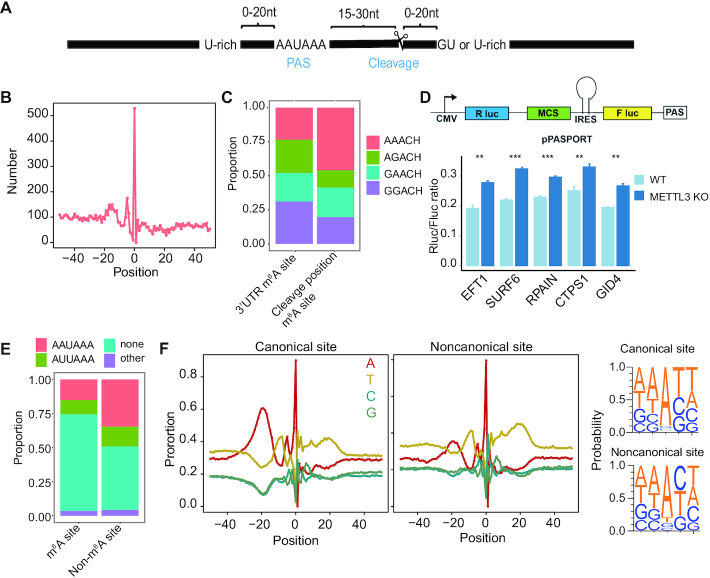
m6A methylation is enriched at non-canonical cleavage sites in 3′UTR. (A) Schematic representation of a poly(A) site and polyadenylation configuration. PAS, poly(A) signals. (B) The distribution of m6A sites around the cleavage sites. Position 0 means the cleavage position. (C) The proportion of m6A sub-motifs at the cleavage position or 3′UTR. (D) Top: Schematic diagram showing the bicistronic luciferase reporter system to measure 3′ processing efficiency. Fragment of interest was inserted into the MCS position (i.e. between Renilla (R luc) and Firefly luciferase (F luc) genes). Efficient mRNA 3′ processing at the tested PAS leads to high expression of Renilla luciferase gene and low expression of Firefly luciferase gene, while poor mRNA 3′ processing results in the opposite mode of gene expression. Therefore, the Renilla/Firefly ratio provides a quantitative measurement of the processing efficiency at the tested PAS. Bottom: Luciferase reporter assays to determine the relative PAS activity of 5 selected sites in wild-type and METTL3 knockout cells. Four biological replicates were performed and statistical significance was calculated using Student's t-test. The relative PAS activities are represented as mean ± sd. **P < 0.01; ***P < 0.001. (E) The proportion of canonical and noncanonical PAS for m6A and non-m6A cleavage sites. Canonical groups: AAUAAA, AUUAAA and other; noncanonical group, none. (F) Left: nucleotide sequence composition around all 3P-seq–identified canonical and noncanonical poly(A) sites. Position 0 means the cleavage position. Cleavage sites located in 3′UTR or 3′UTR downstream 1kb regions were analyzed. Right: The sequence context 2nt upstream and downstream of the cleavage position.